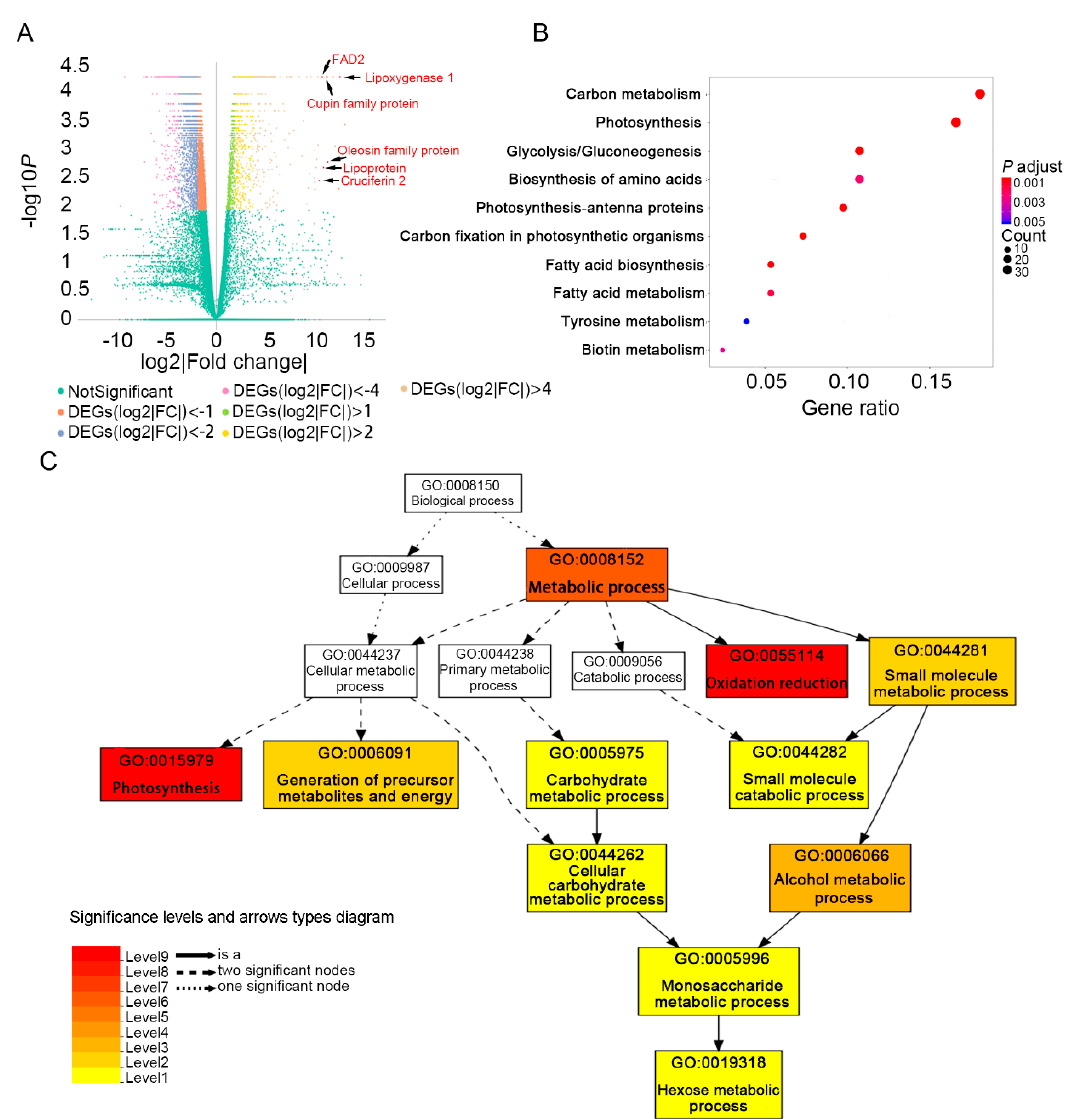
Figure 4. Functional analysis of DEGs comparing 20 DAF with 10 DAF in developing soybean seeds. ( A ) Volcano plot of differentially expressed genes. The x-axis shows log2|Fold change| in expression and the y-axis represents the minus log10 ( P value) of a gene being differentially expressed. log2|Fold change| = log2 (FPKM_ 20 DAF )- log2(FPKM_ 10 DAF ). Genes related to lipid metabolism or lipid storage in the top 10 up-regulated DEGs at 20 DAF vs. 10 DAF are marked by red points and black arrows. ( B ) Top 10 enriched KEGG pathways of up-regulated genes comparing 20 DAF with 10 DAF ( p < 0.01). The colors of dots represent the P values relative to the other displayed pathways and the dot size represents the number of genes in the pathway. The x-axis shows gene ratio and y-axis shows the pathway. Gene ratio is the ratio of up-regulated gene number (comparing 20 DAF with 10 DAF) to the soybean genome-wide number in a certain pathway. ( C ) Gene ontologies (GO) enrichment analysis (in biological process) of up-regulated genes comparing 20 DAF with 10 DAF ( FDR < 0.01). The numbers and names of GO terms are shown in boxes. Box colors indicate levels of statistical significance: Level 1 p = 0.05 , Level 2 p = 5 × 10 − 3 , Level 3 p = 5 × 10 − 4 , Level 4 p = 5 × 10 − 5 , Level 5 p = 5 × 10 − 6 , Level 6 p = 5 × 10 − 7 , Level 7 p = 5 × 10 − 8 , Level 8 p = 5 × 10 − 9 , Level 9 p = 5 × 10 − 10 . Solid, dashed, and dotted lines represent two, one and zero enriched terms at both ends connected by the line, respectively.